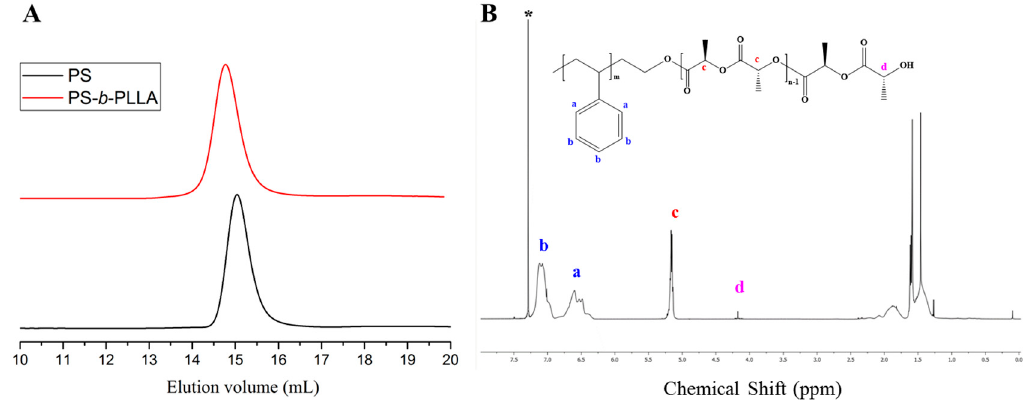
Figure 8. ( A ) SEC traces of PS (black line) synthesized with [ t -BuP 1 ]/[ sec -BuLi]:1/1 and the corresponding PS-b-PLLA (red line); ( B ) 1 H-NMR spectrum of the final diblock copolymer in CDCl 3 .